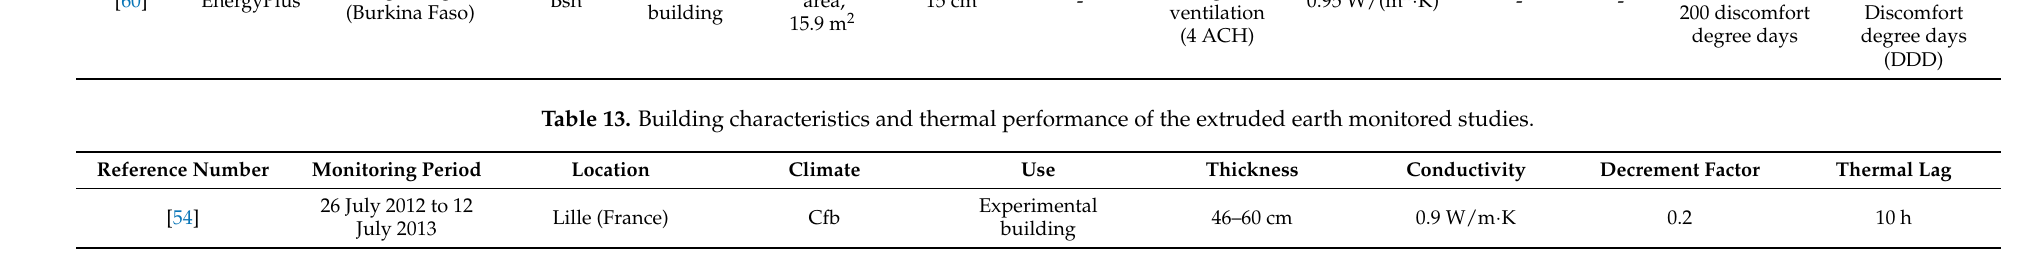
Table 14. Building characteristics and thermal performance of the extruded earth simulated studies.